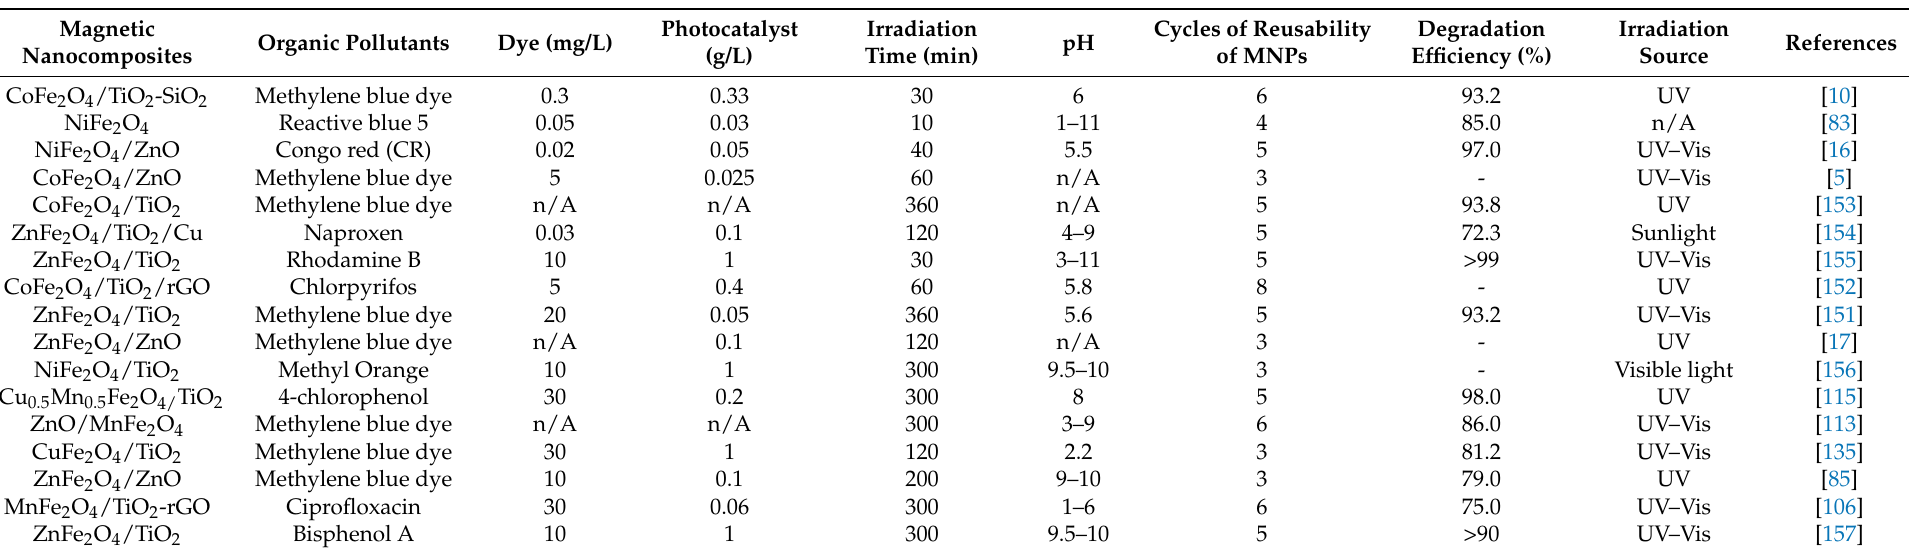
Table 3. Reusability of magnetic nanoparticles (MNPs) for organic pollutants